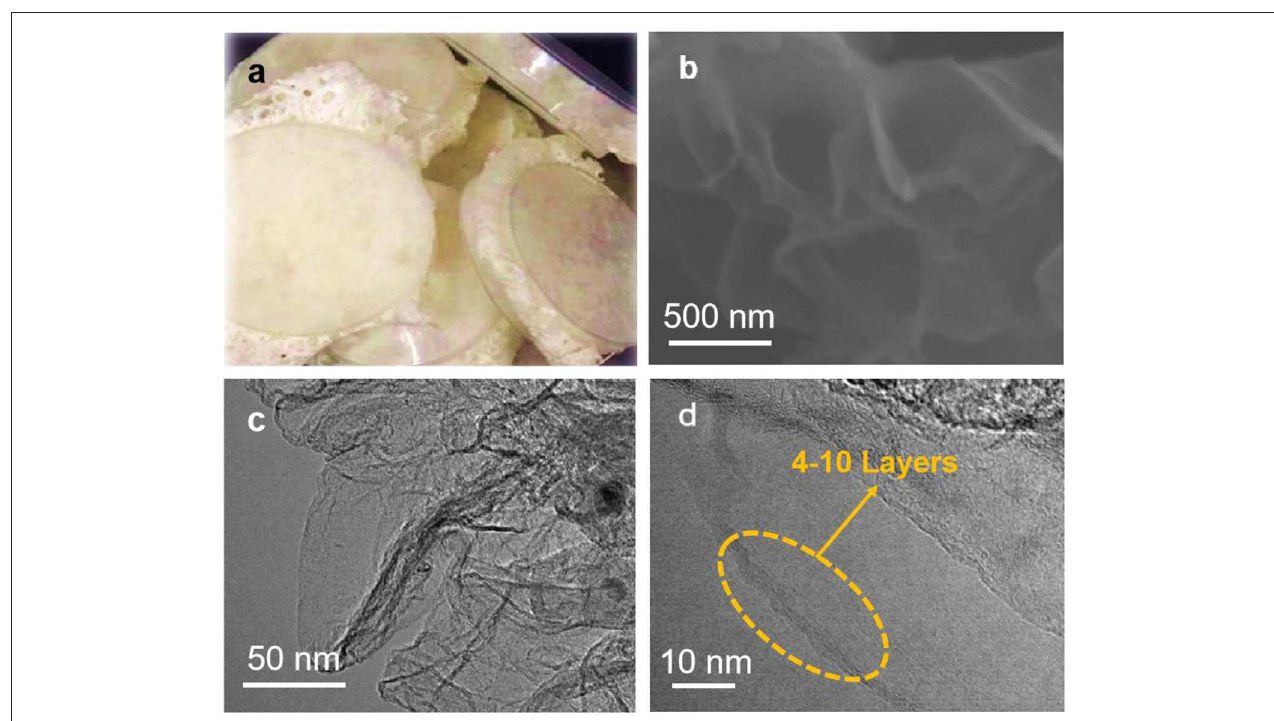
FIGURE 1 | (a) Optical image of freeze-dried chitosan after crosslinking, (b) SEM image of the 3DPG, (c) TEM image, and (d) HRTEM image of 3DPG.